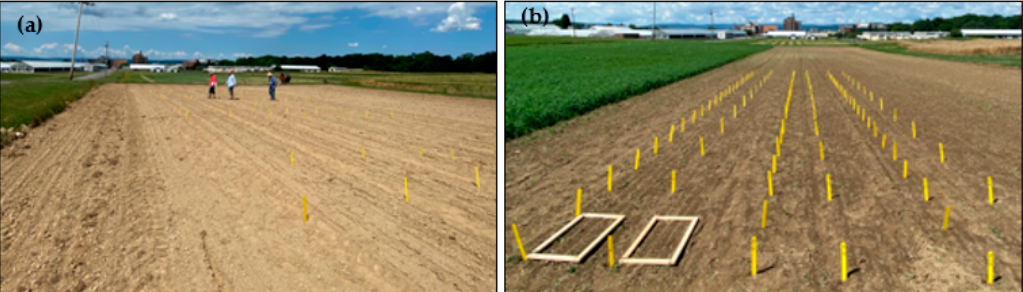
Figure 2. ( a ) Trial 1, planted under warm and dry conditions. ( b ) Trial 2, illustrating the planting wood template, with an area of 30 × 60 cm 2 .